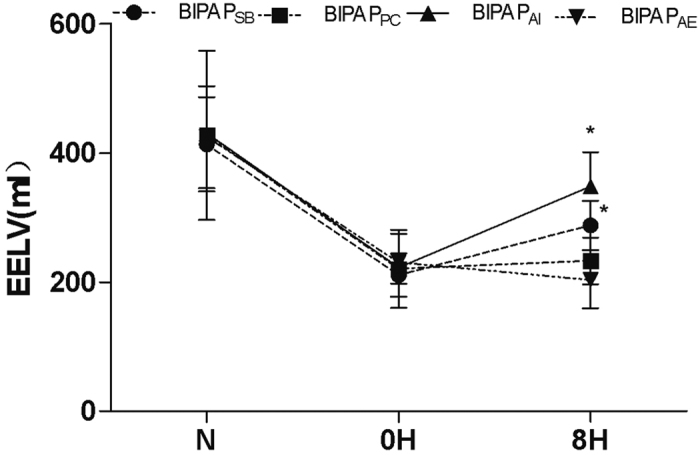
Time course of the dead space volume to tidal volume (VD/VT) ratio in experimental groups (n = 6 per group).BIPAPSB = biphasic positive airway pressure with SB; BIPAPPC = biphasic positive airway pressure with muscles paralysis; BIPAPAI = biphasic positive airway pressure with inspiratory muscles activity; BIPAPAE = biphasic positive airway pressure with expiratory muscles activity. SB = spontaneous breathing; *P < 0.05, vs. other groups.